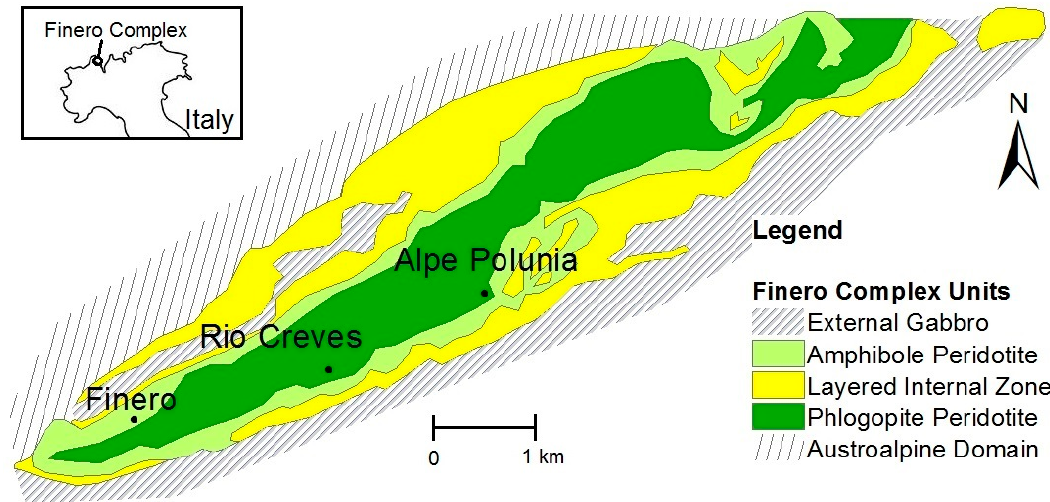
Figure 1. Simplified geological map of the Finero Complex, Ivrea ‐ Verbano Zone, Northern Italy.